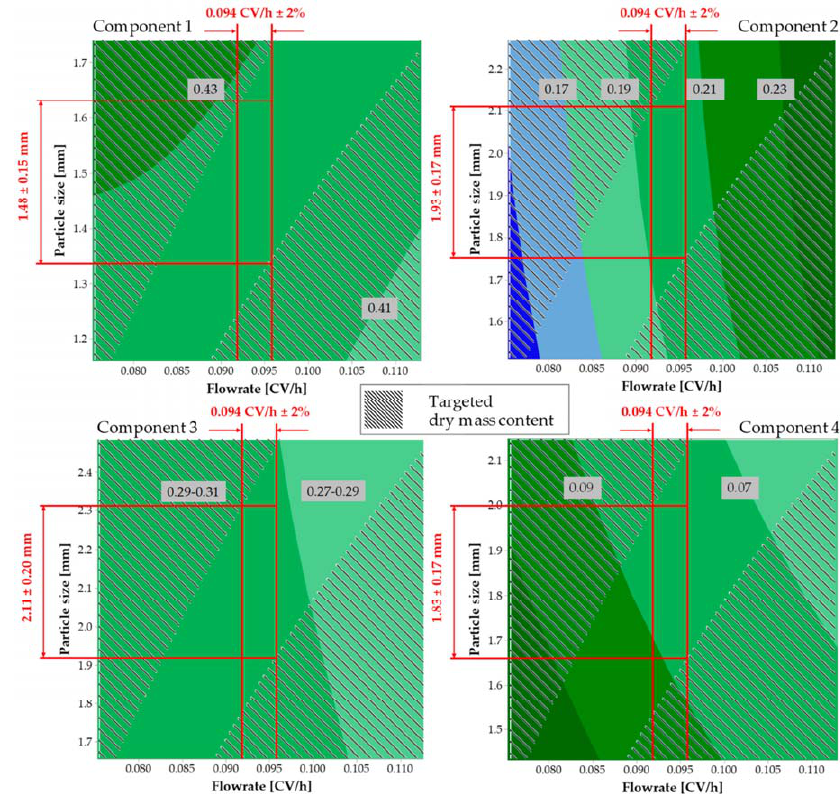
Figure 9. Design spaces for components 1–4 for varying flow rates and particle sizes [40].